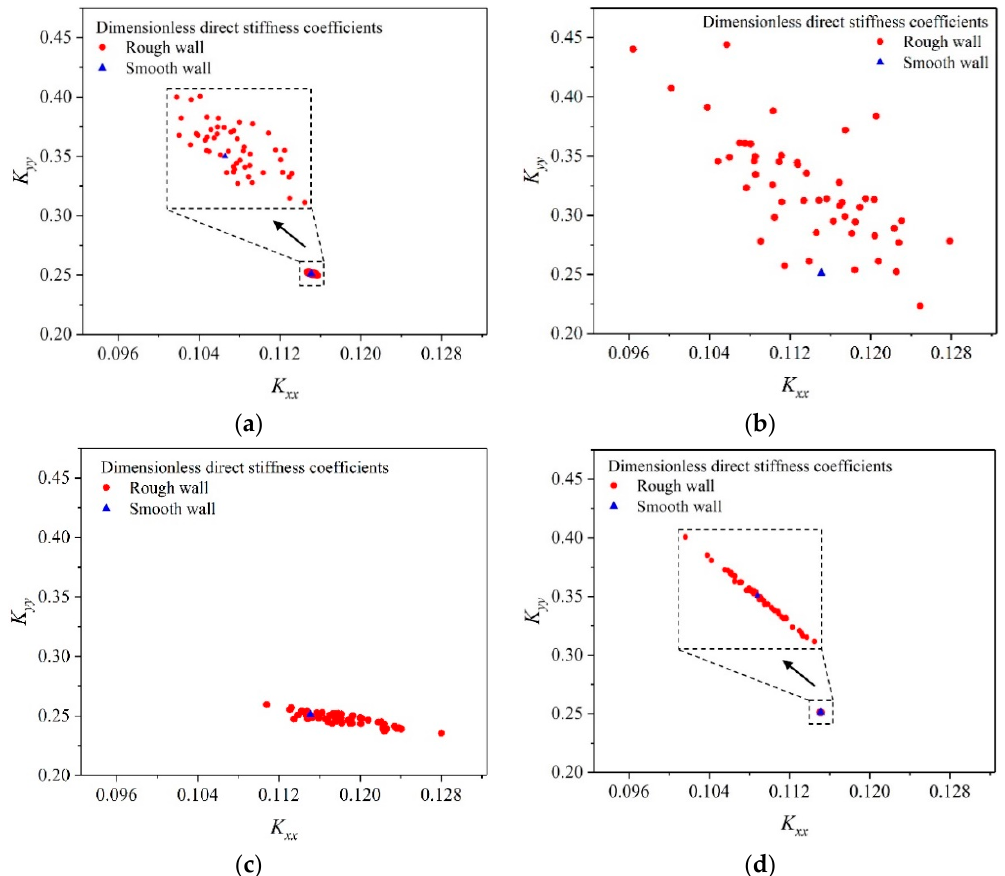
Figure 15. Direct stiffness coefficients distribution with wear in circumferential regions. ( a ) circumferential region 3. ( b ) circumferential region 4. ( c ) circumferential region 5. ( d ) circumferential region 6.